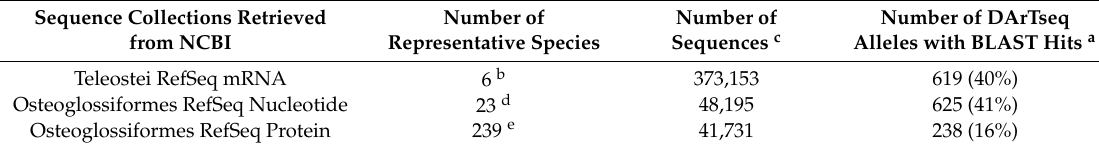
Table 3. Basic local alignment search tool (BLAST) searches of DArTseq (diversity arrays technology sequencing) allele sequences against collections of fish sequences from RefSeq/NCBI database.